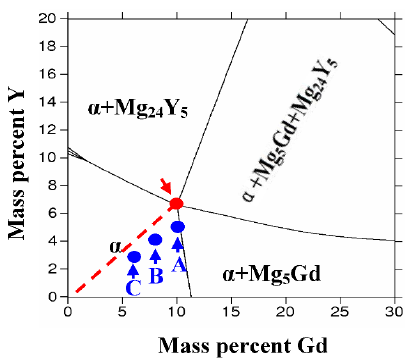
Figure 1. Calculated Mg-Gd-Y-Nd isothermal section at 1.0 wt% Nd at 520 ◦